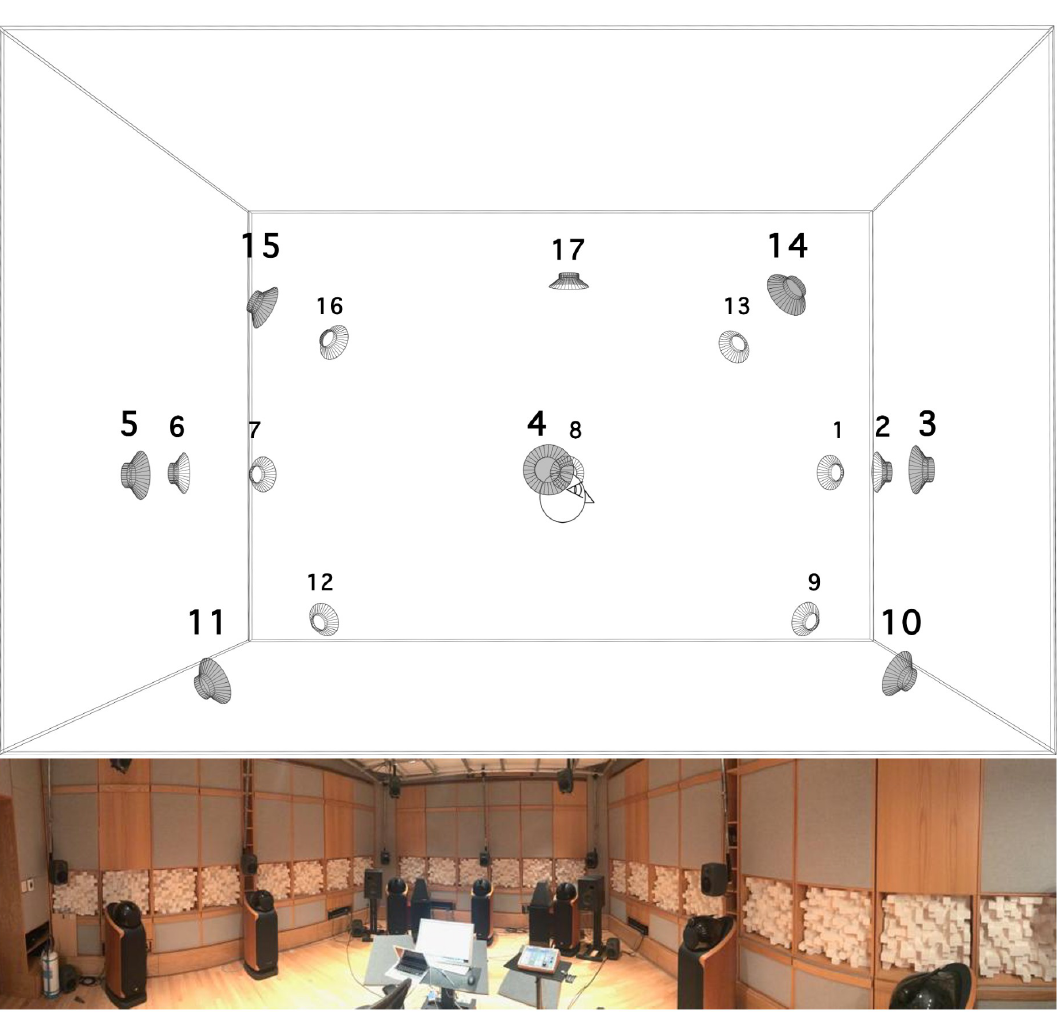
Fig 2. Listening room. Top: diagram of loudspeaker array from the side, simplified head for orientation; bottom: panoramic photograph of the room from the back right corner (original copyright: Gre´goire Blanc [2019] under a CC BY 4.0